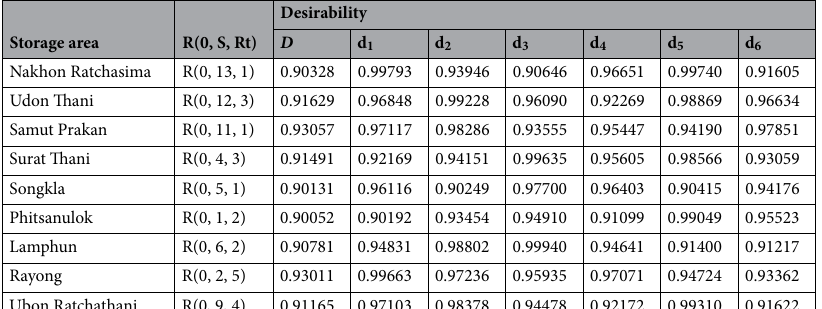
Figure 3. Pseudo code of LNS-VOA metaheuristic.